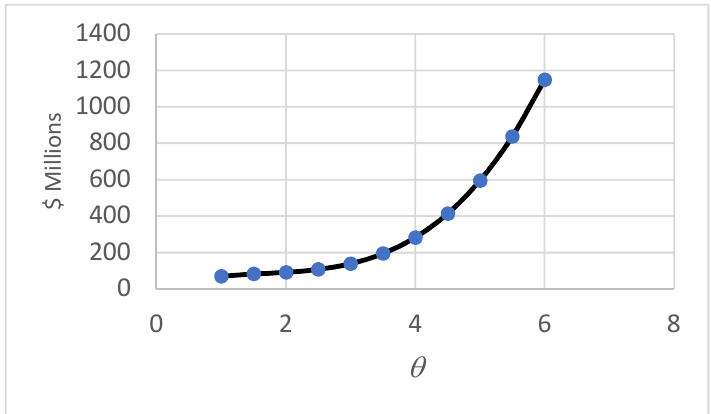
Figure 3. The prevent value in Dollars of the net utility gain with changes in θ . (Discount rate r = 0.03 and α = 0.69 and α = 0.66 as per text).